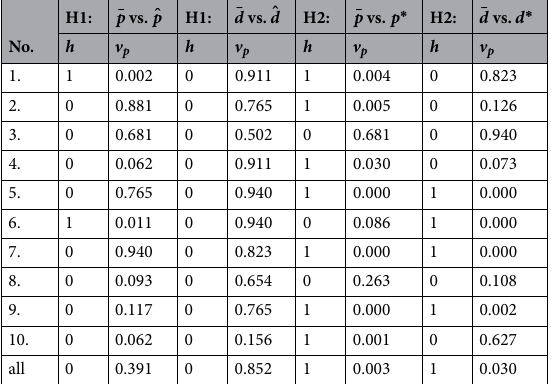
Table 2. Comparison of the experimentally fitted control gains ( ¯ p , ¯ d ) to ( ˆ p , ˆ d ) (H1) and to ( p ∗ , d ∗ ) (H2) by means of Wilcoxon signed-rank test: rejection of H1 and H2 is indicated by h ( h = 0 means that significant difference is not proven statistically, h = 1 means that there is statistical difference), p-value ( v p